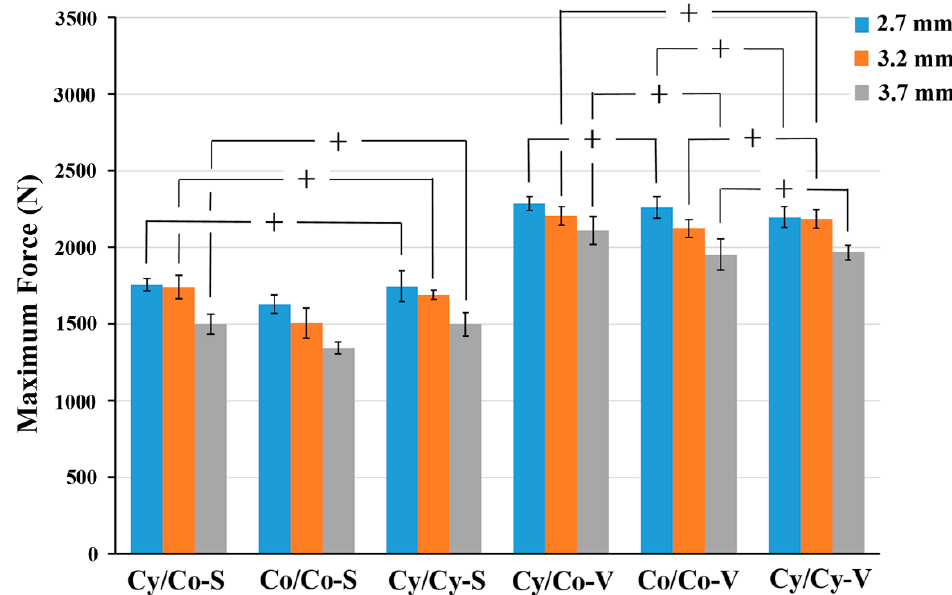
Figure 8. Mean ultimate pullout strength for screws of various geometries inserted in 2.7-mm, 3.2-mm and 3.7-mm pilot holes using 20-pcf test blocks. Groups without significant differences are indicated with the ‘‘+” symbol.